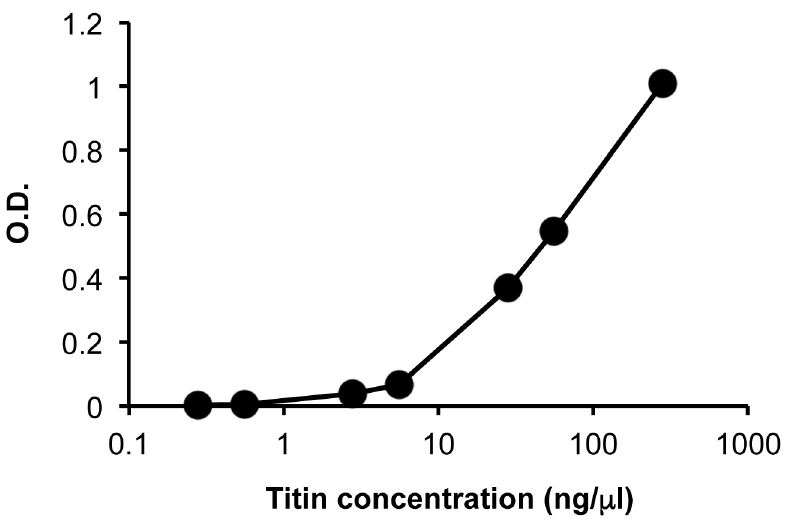
Fig 4. A typical standard curve for the measurement of the N-terminal fragment of human titin. We established an ELISA to measurethe concentration of the N-terminal fragment of humantitin using anti- humantitin monoclonal antibodies7D3 and 2B3. The GST-tagged recombinant human titin (amino acids 1–111)was detected with the ELISA in a concentration-dependent manner.